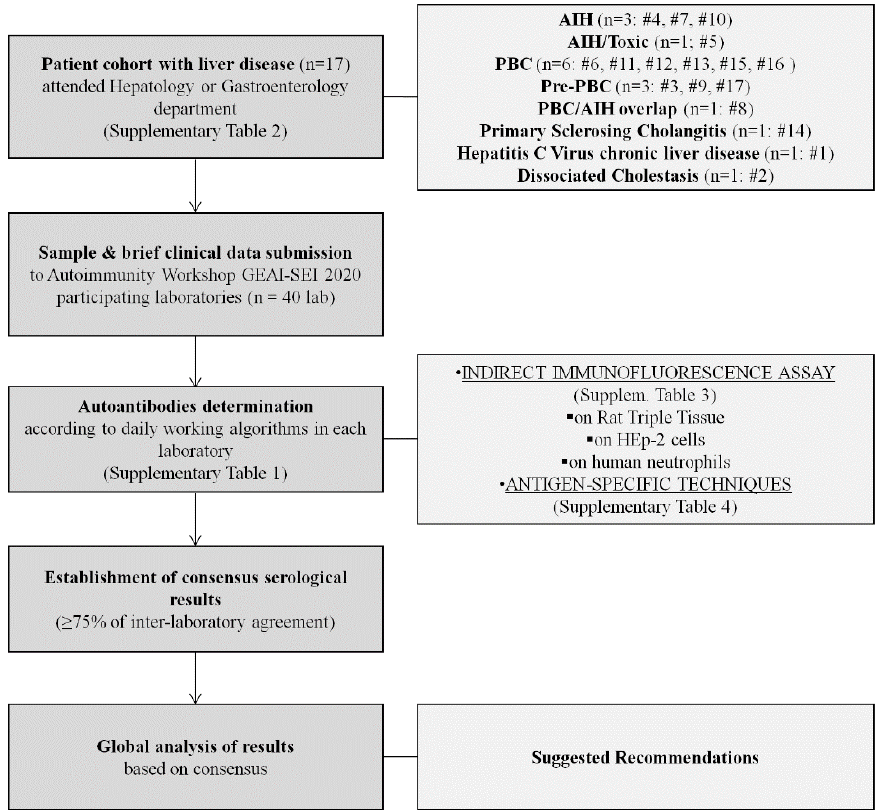
Figure 2. Flow-chart of Autoimmunity Workshop GEAI-SEI 2020. Abbreviations: AIH, autoimmune hepatitis; PBC, primary biliary cholangitis.